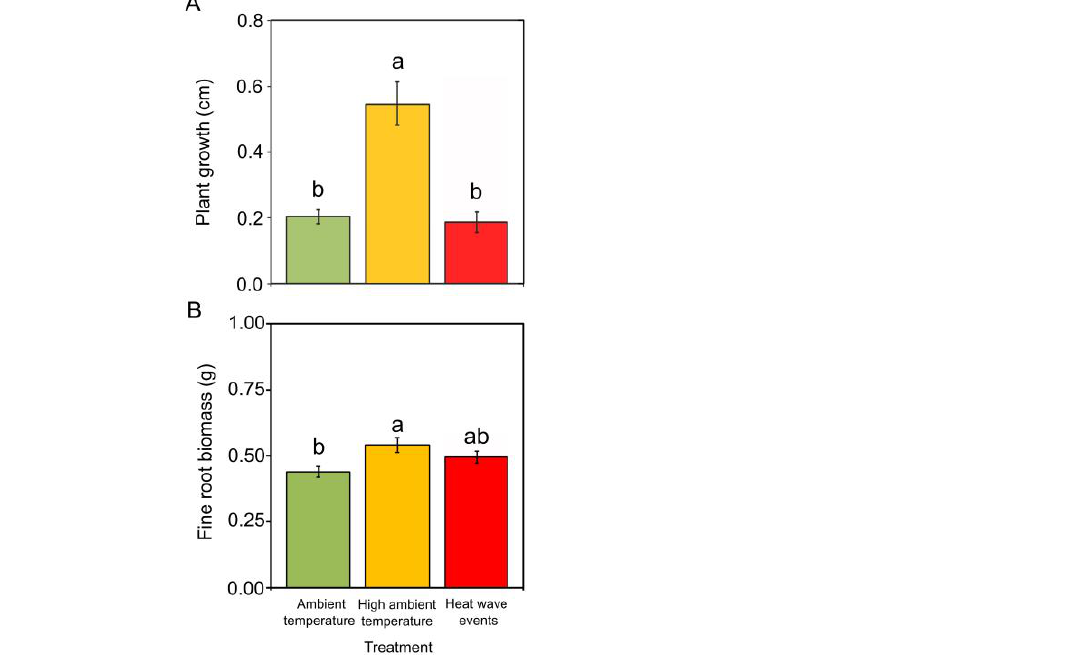
Figure 1. Plant growth ( A ) and fine root biomass ( B ) of six-month-old Castanea sativa seedlings exposed to ambient temperature (green), high ambient temperature (orange) and two heat waves (red). Vertical bars are standard errors, and different letters indicate significant differences between means (Tukey’s HSD tests at p < 0.05). On day 0, photosynthetic rates ( P n ) and transpiration rates ( E ) were similar irrespec- tive of the warming treatment (Figure 2A and B), whereas stomatal conductance ( g s ) val- ues increased significantly in plants under high ambient temperature compared to plants under ambient temperature ( p < 0.05; Figure 2C). On day 10, P n , E and g s values of seed- lings under high ambient temperature and heat wave event scenarios were significantly lower than in seedlings under ambient temperature ( p < 0.05; Figure 2). No differences were observed in plant growth, root biomass or leaf exchange parameters between fami- lies (results not shown). The phenolic compound profiling of seedlings differed depending on the warming scenario, mother tree and sampling time. Eleven of the 21 compounds identified in leaves and roots (Table 1) varied depending on the warming scenario (Table 2). More phenolic compounds showed changes in leaves than in roots (eight vs. three, respectively; Table 2).